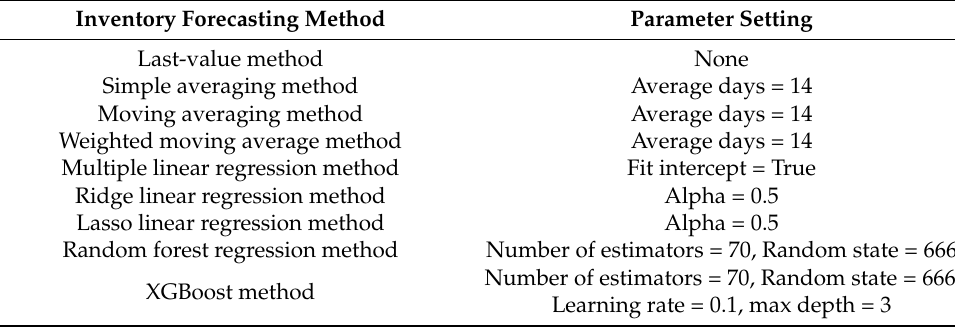
Table 4. Parameter settings for each AI